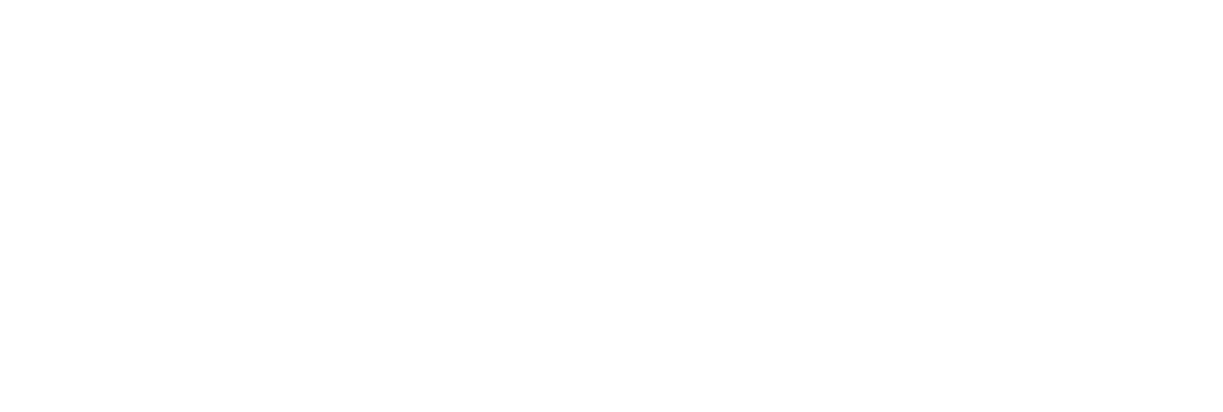
Frontiers in Neuroscience | Brain Imaging